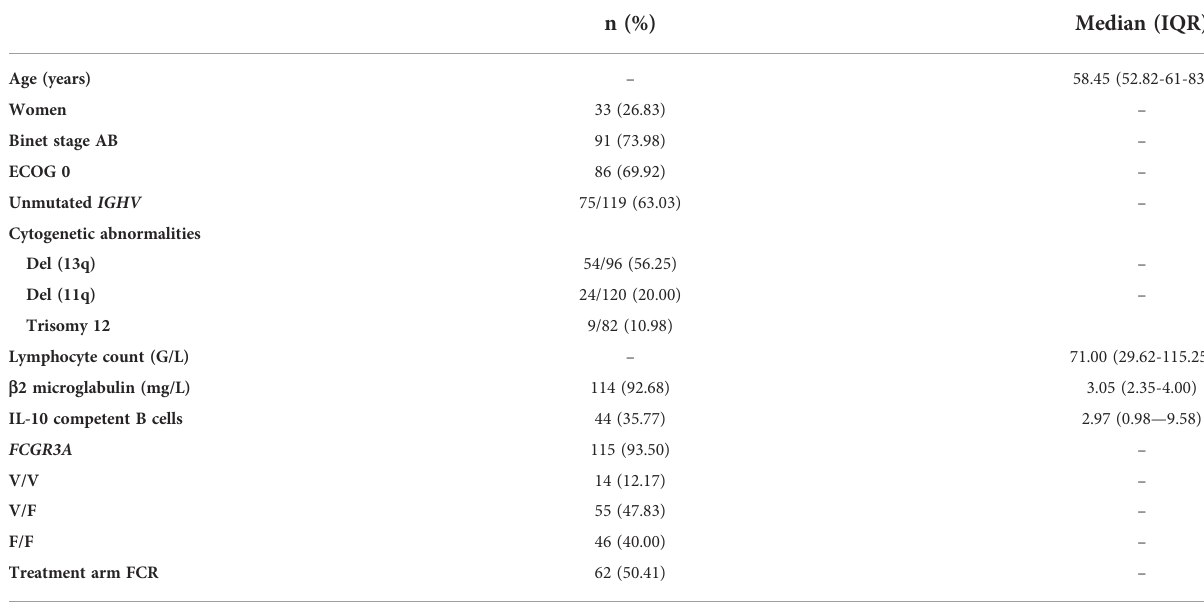
TABLE 1 Patients ’